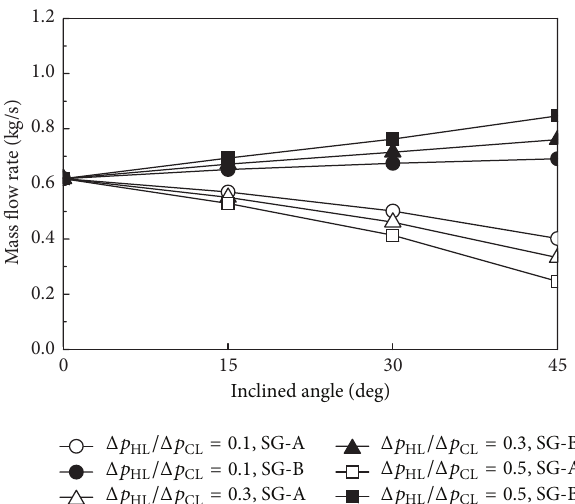
Figure 13: Effect of flow resistance distribution (experimental